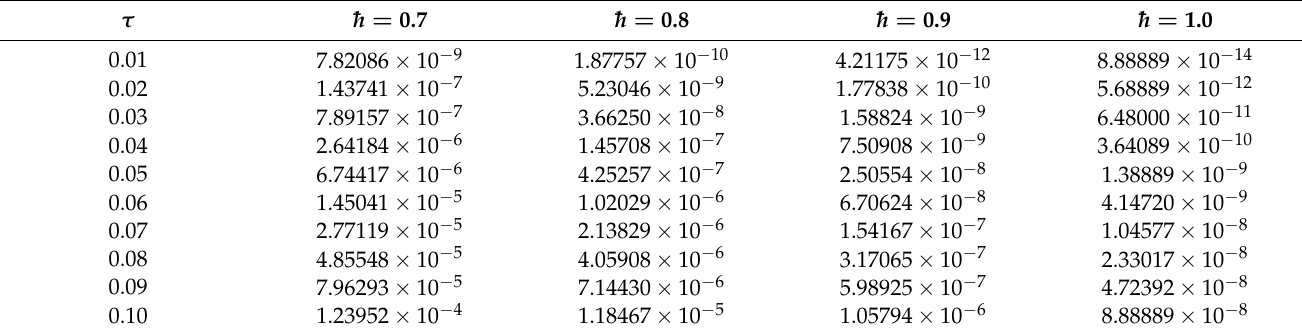
Table 9. The | Ω 6 ( α , τ ) − Ω 5 ( α , τ ) | of Problem 4.3 at varying values of ¯ h at α = 1.0 when ξ = 2.0 determined by the ARPSM at plausible locations in the range τ ∈ [ 0, 0.10 ] .